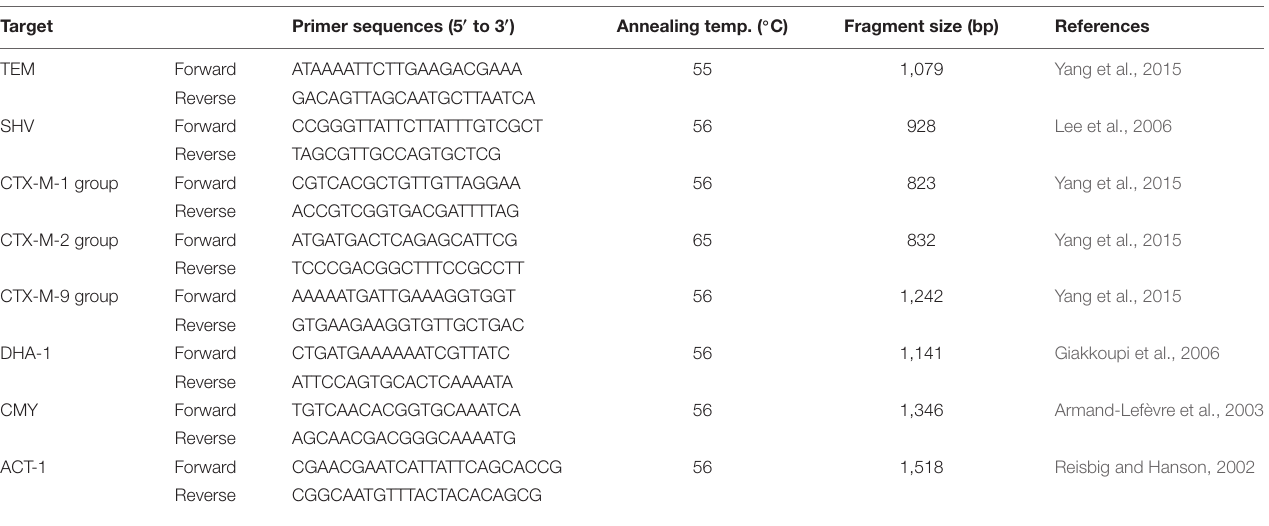
TABLE 1 | Polymerase chain reaction (PCR) primers used for detecting antibiotic resistance genes.